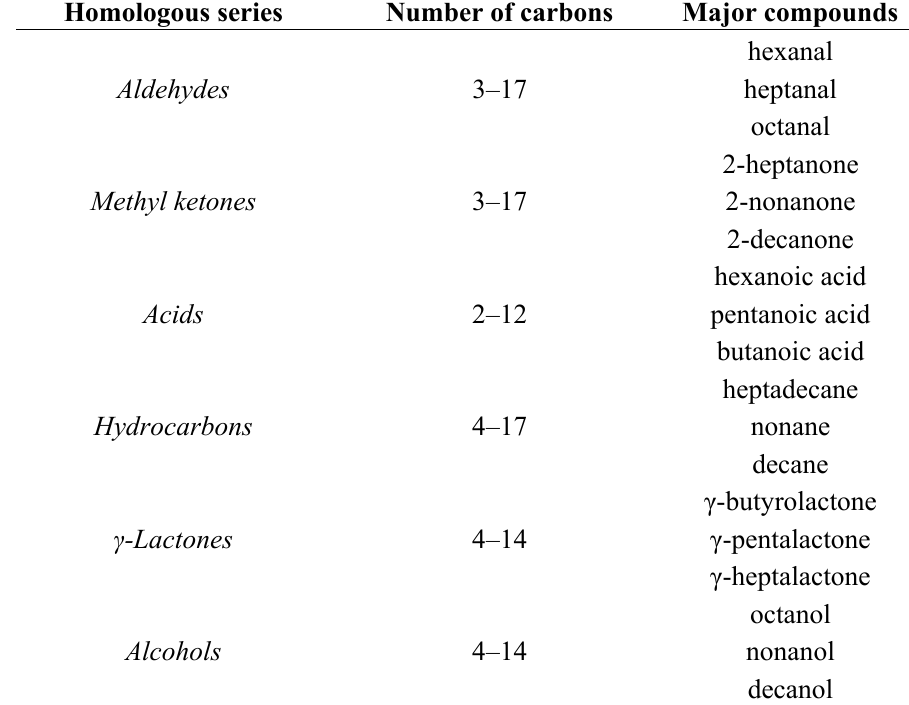
Table 1. Volatile compounds produced by heating tristearin to 192 °C. From [9], by permission of Taylor & Francis